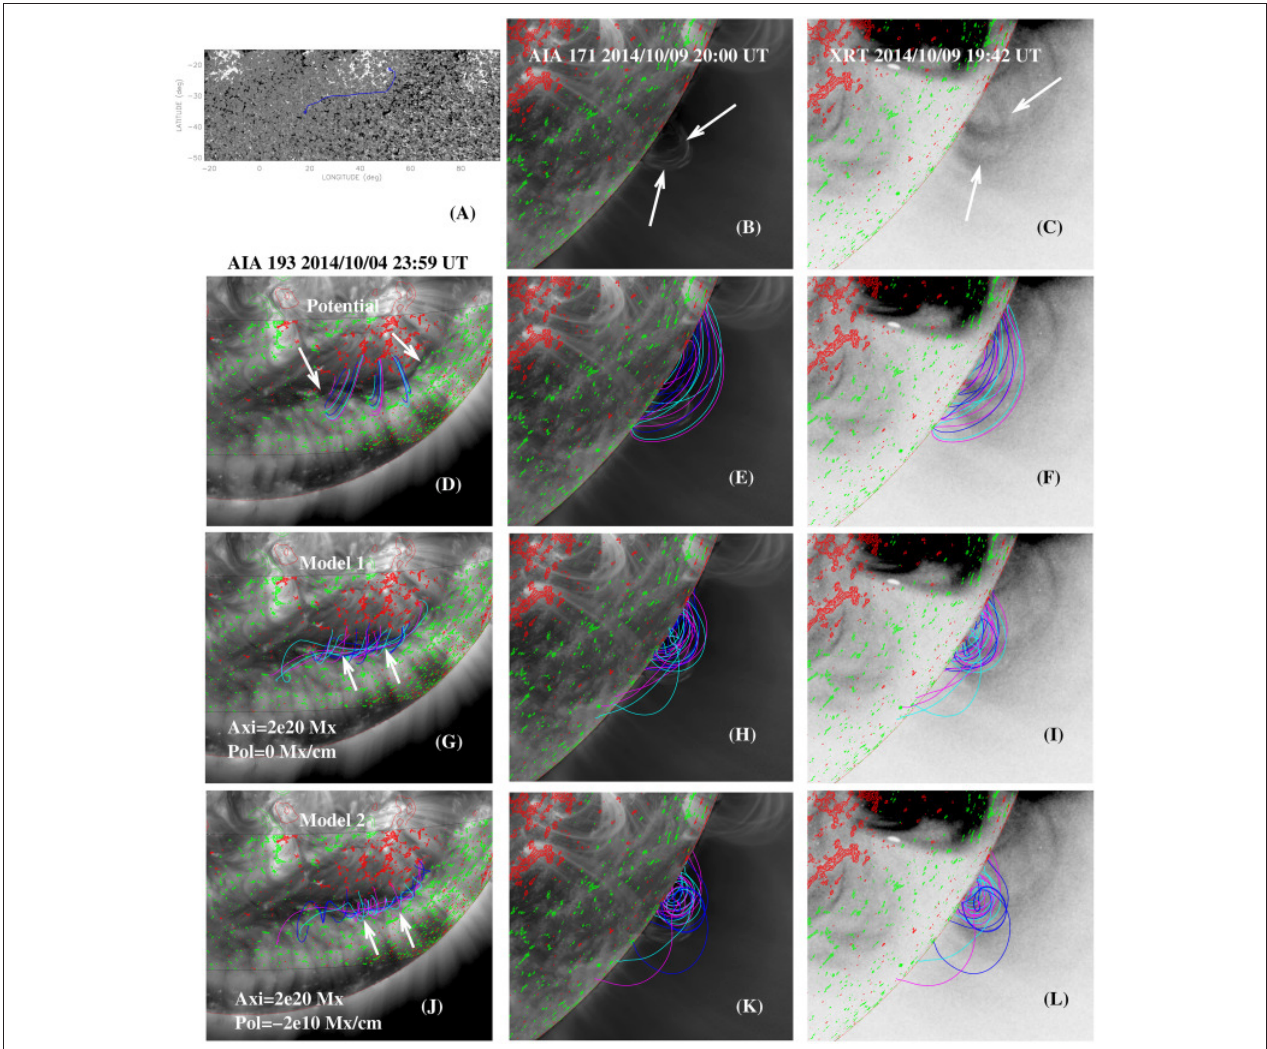
FIGURE 9 | Magnetic field models constructed using the flux rope insertion method in comparison to observations. The models use combined LOS magnetograms observed by SDO/HMI from 2014 October 2 to October 5 at 19:00 UT. Panel (A) grayscale map of the LOS magnetic field with positive (white) and negative (black). The blue curve is the path of the flux rope and the circles indicate the footpoints of the flux tube. The bottom three rows show color contours of the magnetogram as positive (red) and negative (green) overlay on AIA 193 Å taken at 23:59 UT on October 4 (left) , AIA 171 Å taken at 20:00 UT on October 9 (middle) , and Hinode/XRT Be-thin taken at 19:42 UT on October 9 (right) with the color lines referring to selected magnetic field lines. Panels (B,C) AIA 171 Å observations and XRT Be-thin observations with arrows pointing out plasma motions and the coronal cavity. The color lines in the bottom rows refer to selected magnetic field lines from the potential field (D–F) , Model 1 (G–I) , and Model 2 (J–L) .